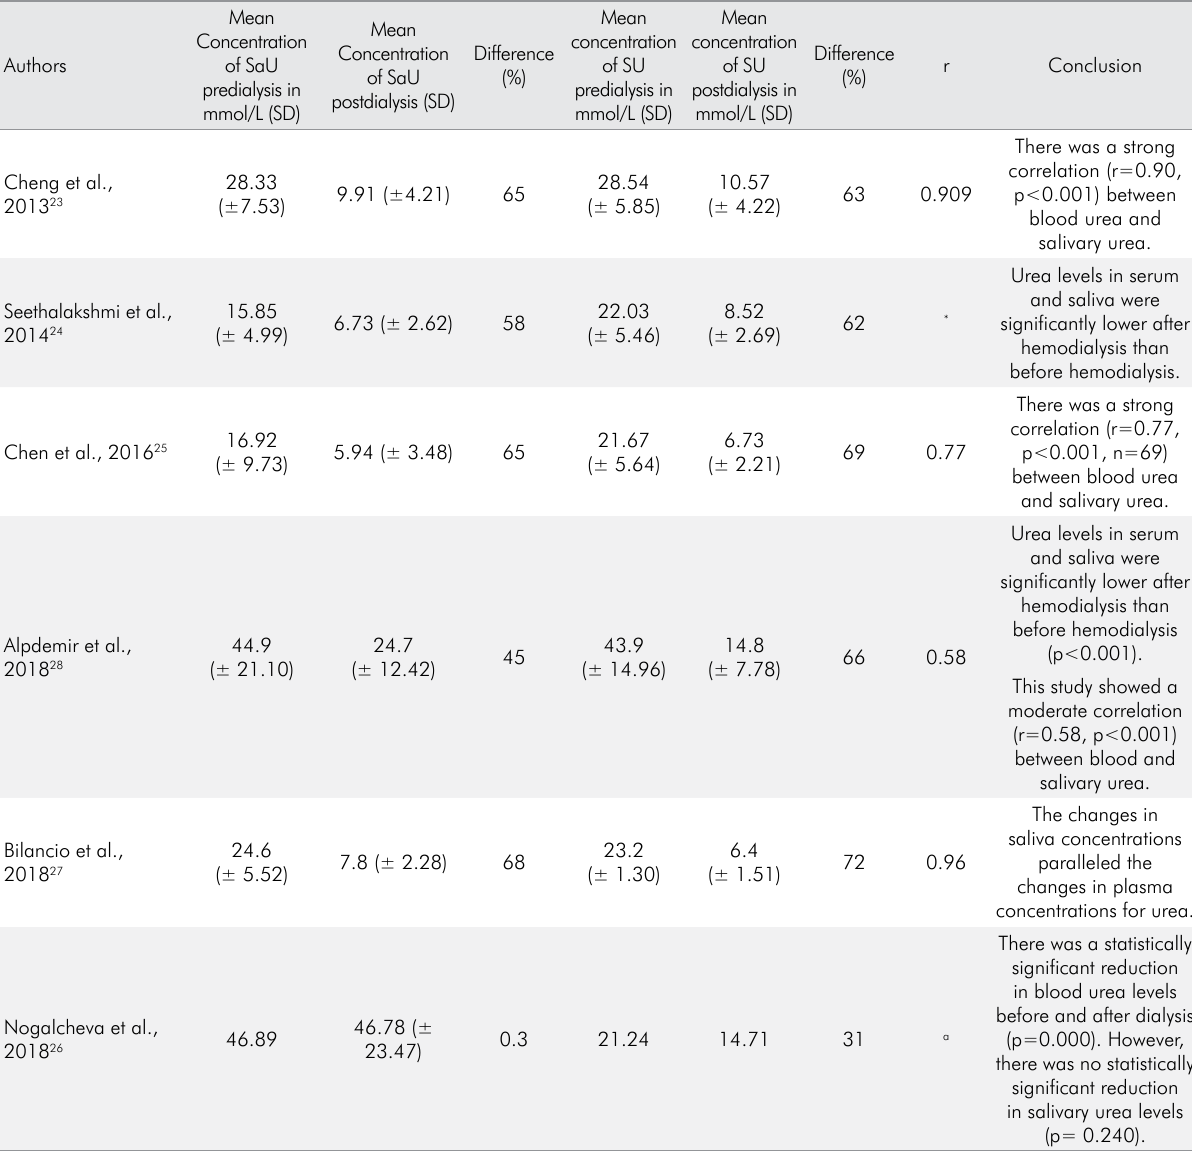
Table 3. Main results of the eligible studies investigating urea